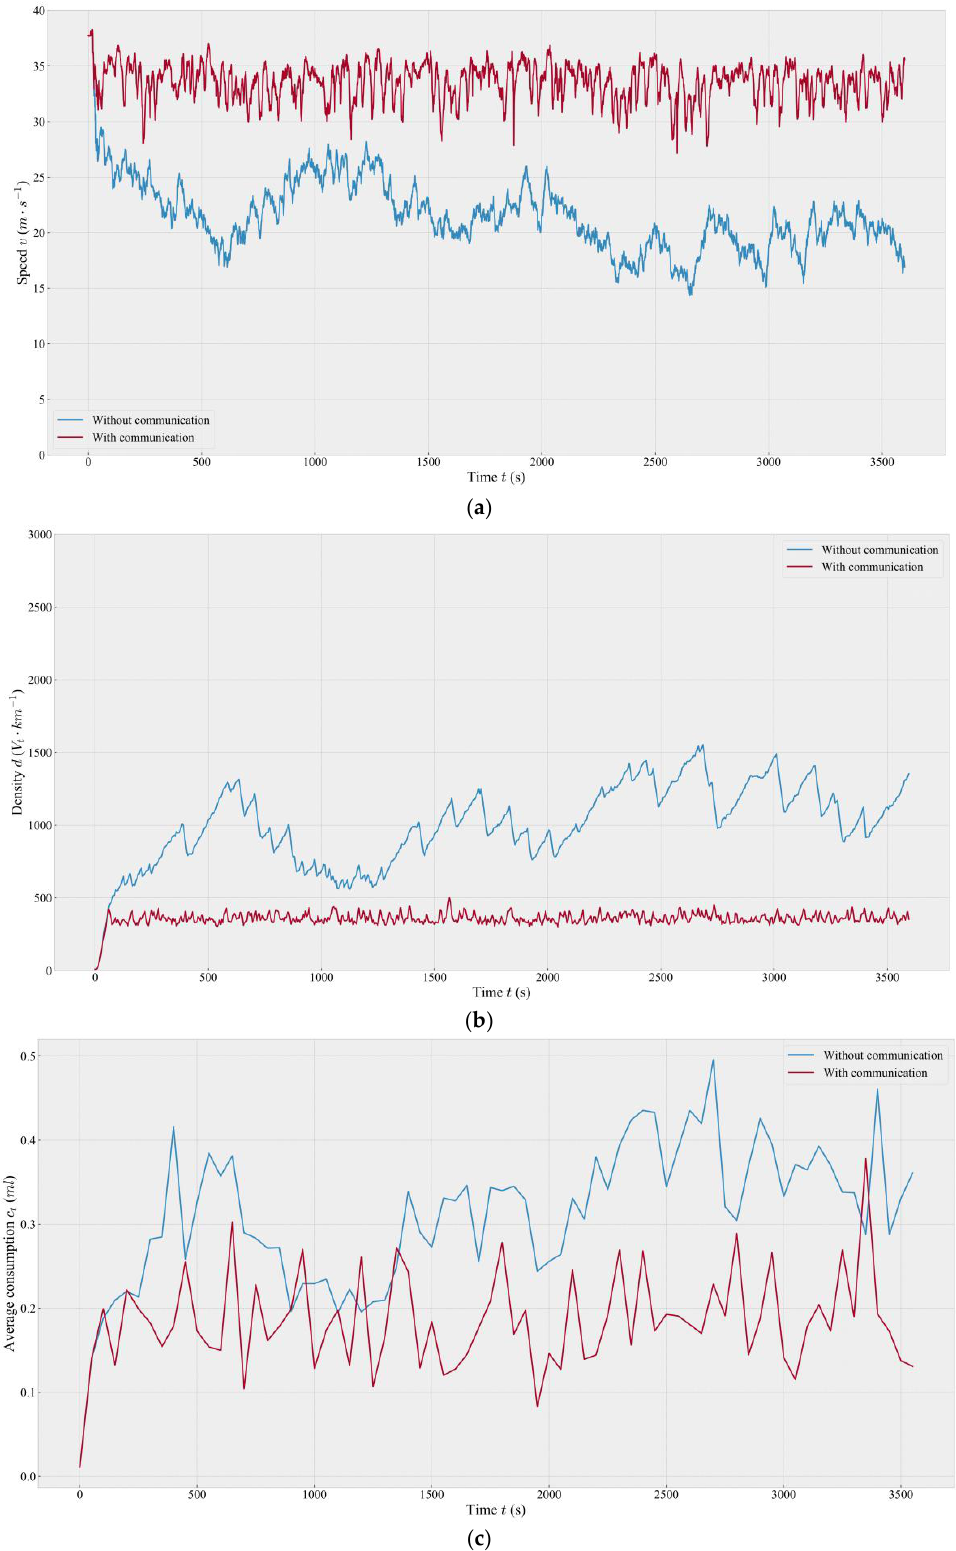
Figure 12. Simulation with 1500 vehicles/hour per lane. ( a ) Average speed; ( b ) Traffic density; and ( c ) Average